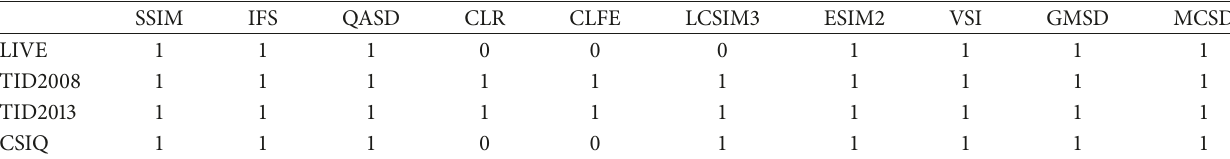
Table 3: Statistical significance tests.